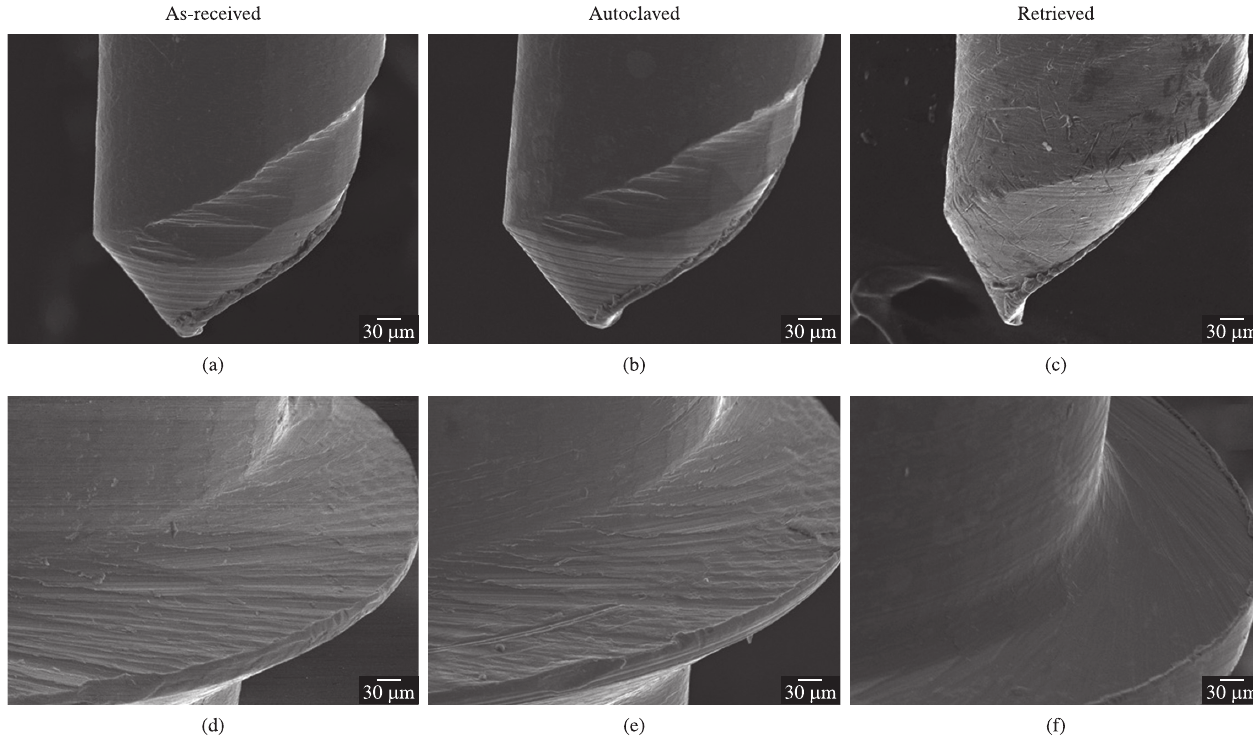
Figure 3. SEM photomicrographs of the surface morphology of mini-implants used in the present study: a) tip of as-received mini-implant; b) tip of autoclaved mini-implant; c) tip of retrieved mini-implant (used for 11 months); d) thread of as-received mini-implant; e) thread of autoclaved mini-implant; and f) thread of retrieved mini-implant (used for 11 months). Original magnification was at 250×.